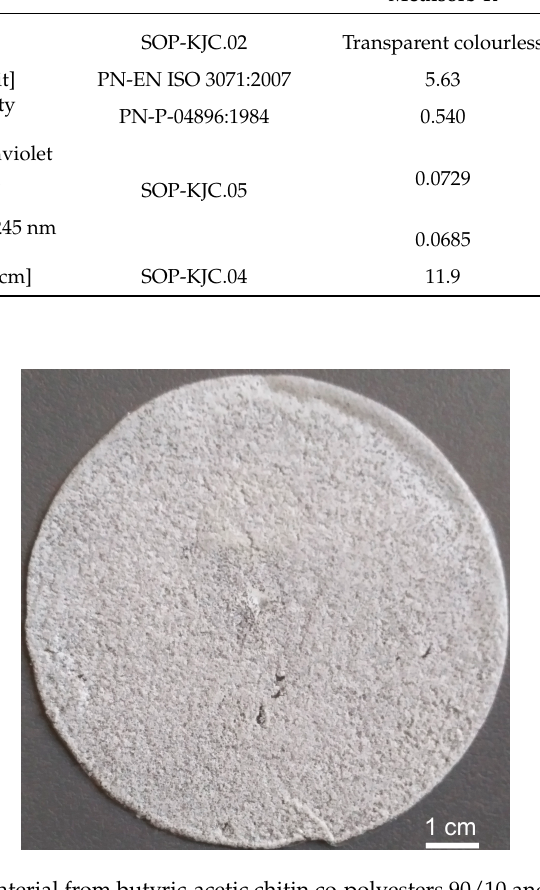
Figure 4. The porous material from butyric-acetic chitin co-polyesters 90/10 and NaCl as the porophor agent in the membrane form.